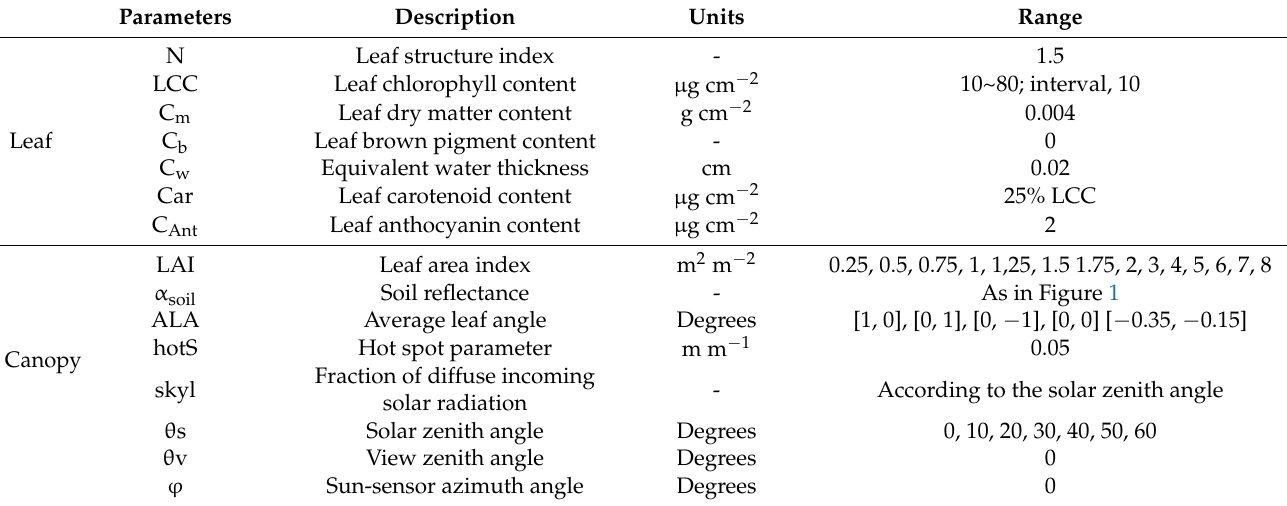
Table 5. Configuration of the input parameters in the PROSAIL-D